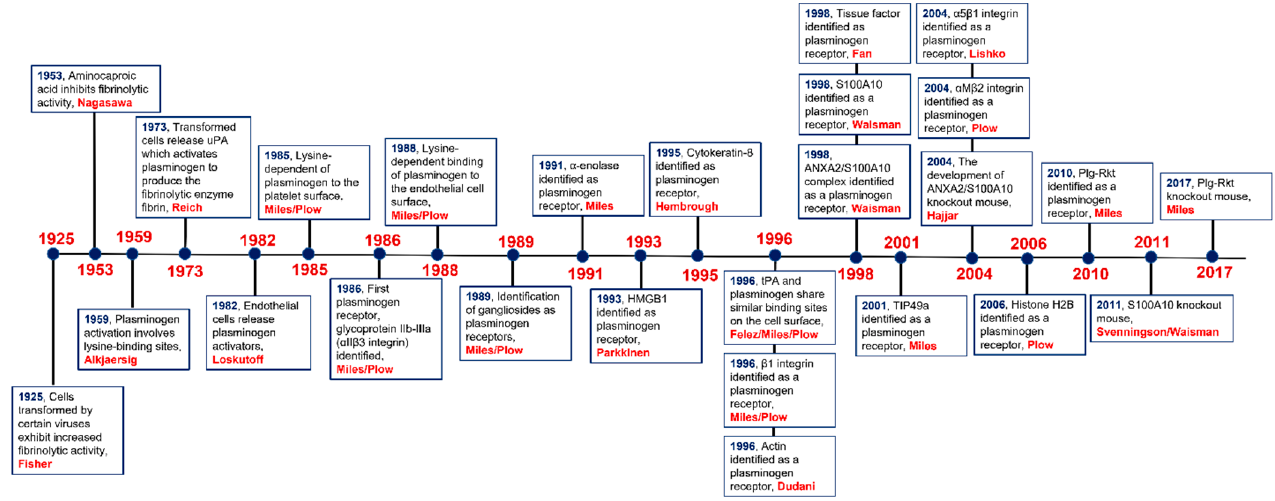
Figure 1. Chronology of the major discoveries in the plasminogen receptor field. The mechanism of interaction of plasminogen with plasminogen receptors has been evaluated in detail by Law [24]. They reported the crystal structure of plasminogen and suggested that K1 mediates the initial docking of plasminogen with fibrin or the cell sur- face. Law also reported that K5 is transiently exposed in plasminogen, such that it could